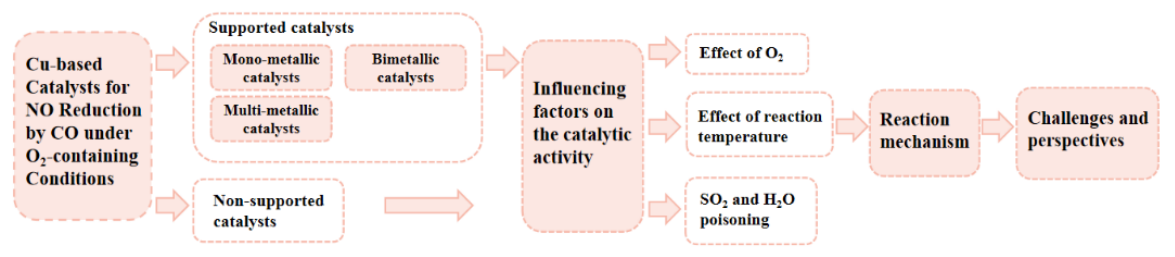
Figure 1. Schematic illustration of the review of Cu-based catalysts for NO reduction by CO under O 2 -containing conditions.